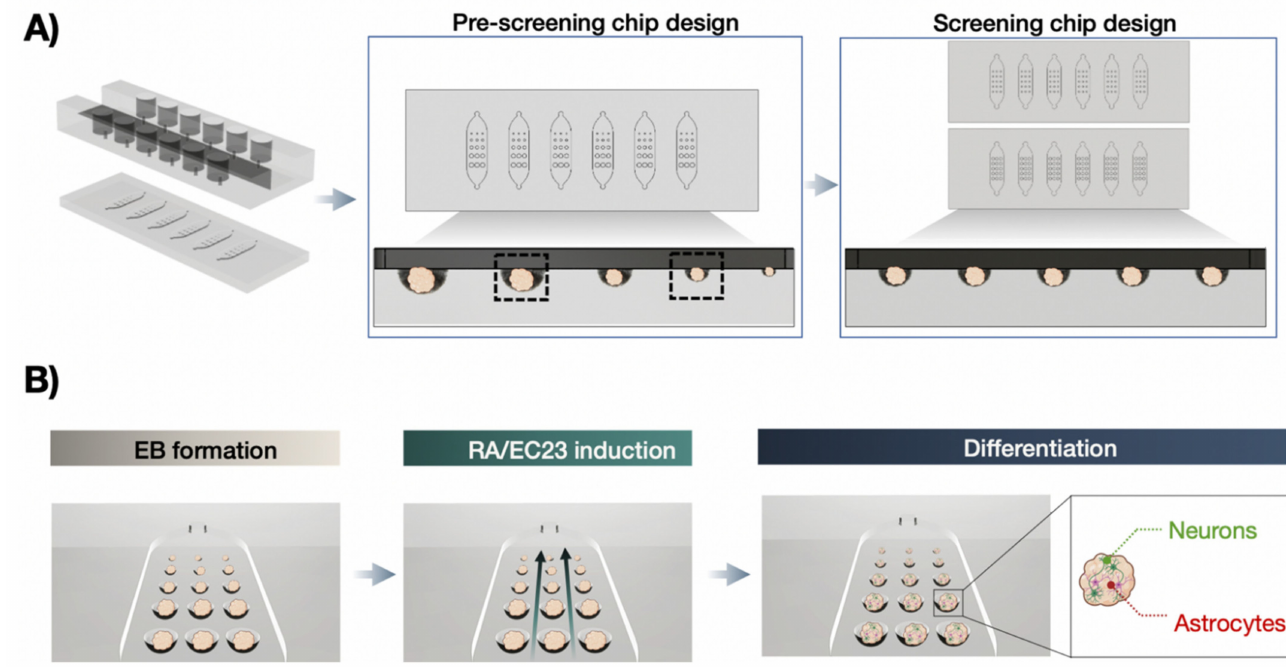
Figure 1. ( A ) Microfluidic biochip array concepts using a pre-screening chip design of multiple cavity sizes for embryoid body (EB) size optimization and two screening chip designs consisting of a single microcavity size on each individual chip. ( B) Workflow of on-chip differentiation protocol including EB formation, exposure with neuralizing inducers retinoic acid (RA) or EC23, followed by differentiation in neurons and astrocytes. Created with